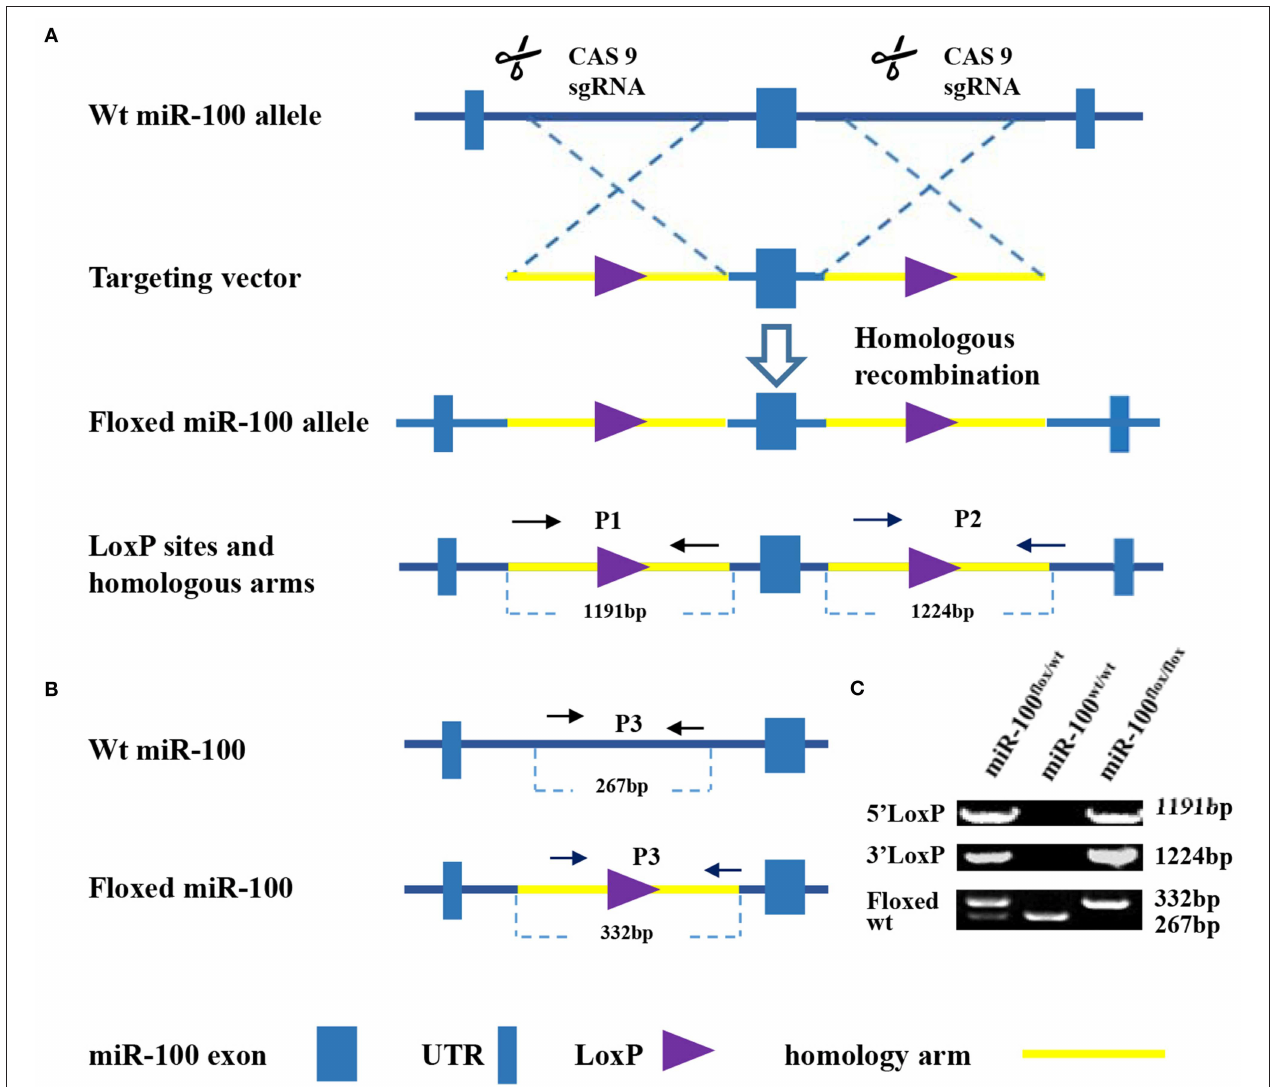
FIGURE 1 | Strategy for generation of a condition knockout of miR-100. (A) Schematic diagram of the wild type mir-100 allele (top), the miR-100 gene targeting vector (middle), the floxed miR-100 allele (bottom). Two loxP sites (purple triangle) flanking miR-100 exon (blue square) within 5 ′ and 3 ′ homology arms (yellow, 1191 and 1,124kb, respectively) are indicated. (B) Multiple PCR based genotyping. Primers with the expected product size are indicated. Primers 1 and 2 were used to detect the presence of 5 ′ (1,191 bp) and 3 ′ (1,224 bp) homologous arms of the targeted miR-100 allele. Primers 3 were used to distinguish floxed miR-100 allele